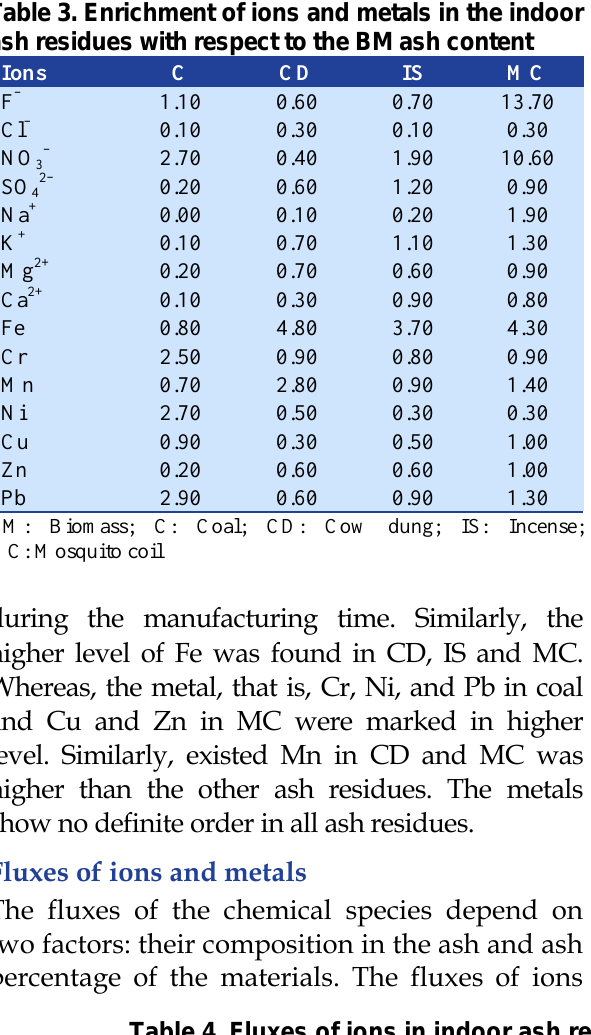
Table 4. Fluxes of ions in indoor ash residues (g/kg)